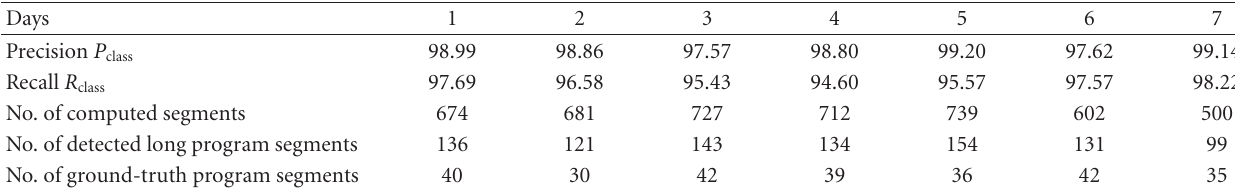
Table 6: Evaluation of the ILP-based technique in detecting long program segments on TVTest